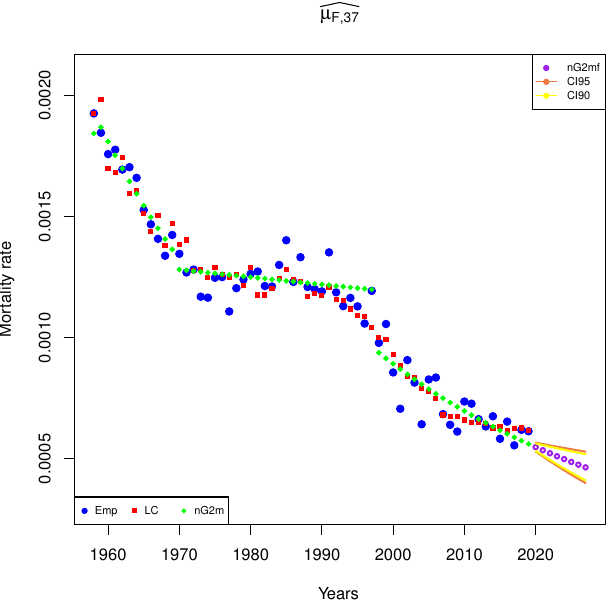
Figure 2. The values of mortality rates—female, age 37: empirical (Emp), theoretical (LC, nGMs), forecasts (nGMsf), and c. interval based on the LC, and nGM model with Markov